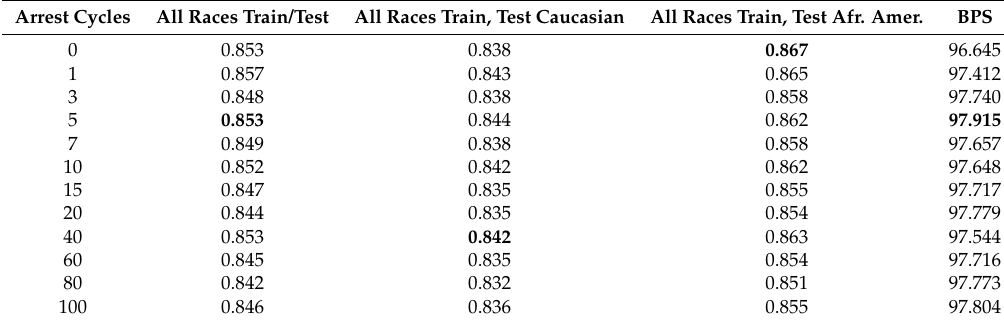
Table 2. Average positive predictive rate.